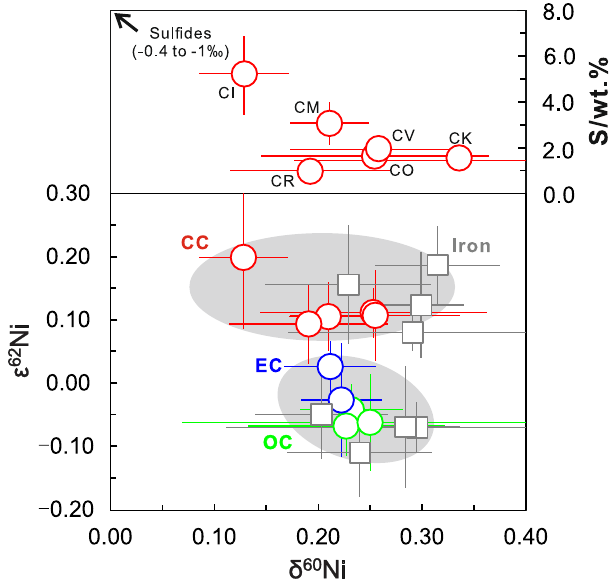
Fig. 1 A summary of mass-independent and mass-dependent Ni isotopic variations in meteorites. The ε 62 Ni ( ε 62 Ni = ( 62/58 Ni sample / 62/58 Ni SRM986 − 1) × 10 6 after internal normalization to 61 Ni/ 58 Ni), are from literature 31 – 33,35,36 , and the δ 60 Ni of chondrites and iron meteorites are from this study and literature 37 – 41,70 . The carbonaceous chondrites (CC), enstatite chondrites (EC), and ordinary chondrites (OC) have average δ 60 Ni values of 0.23 ± 0.14 ‰ (2 SD), 0.22 ± 0.02 ‰ (2 SD) and 0.24 ± 0.02 ‰ (2 SD), respectively. A roughly negative correlation